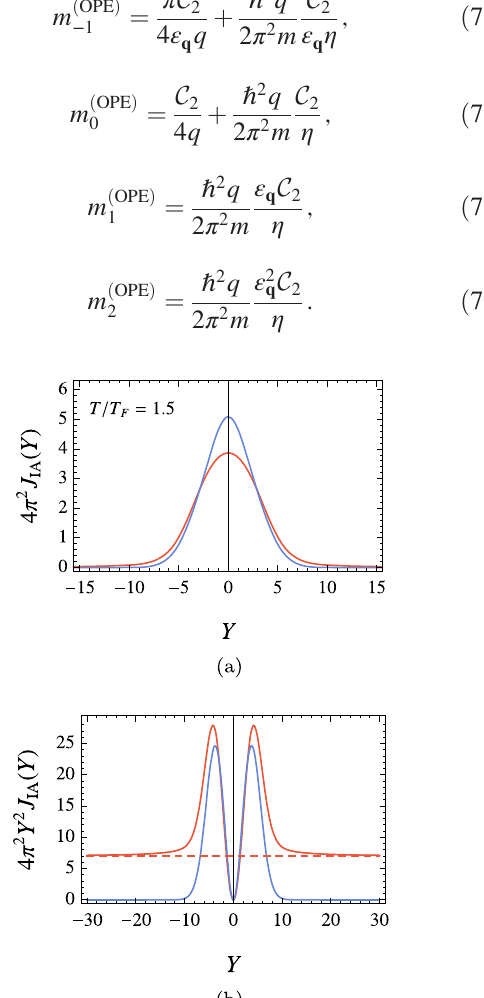
FIG. 10. (a) Impulse approximation Y -scaling function J for IA the nondegenerate Fermi gas at unitarity. The red line denotes the 1 . 5 . For scaling function of the interacting gas with T=T F ¼ comparison, we include the scaling function of a noninteracting Fermi gas with the same density. (b) The power-law 1 =Y 2 tail Eq. (11) of the interacting gas. The dashed red line marks the C 14 . 045 asymptotic behavior with λ 4 2 ¼ T